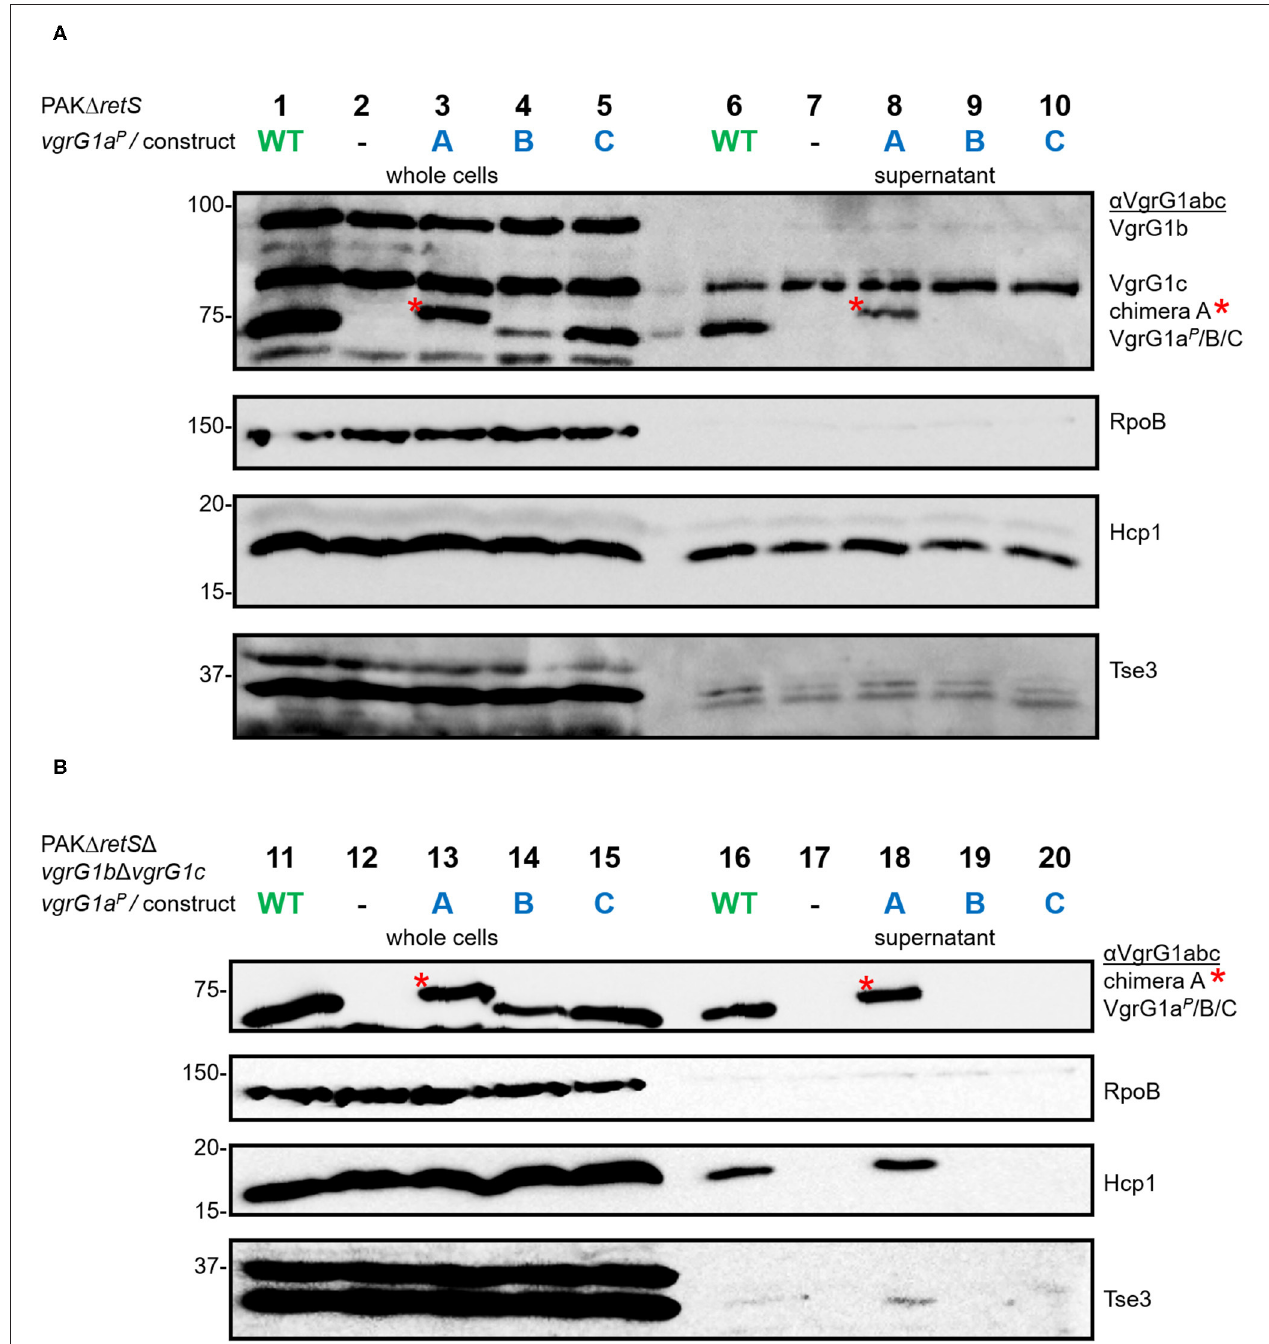
FIGURE 3 | Modifying the C-terminus of VgrG1a inhibits T6SS functionality. Representative figures of western blots from three independent secretion assays of (A) PAK 1 retS and (B) PAK 1 retS 1 vgrG1b 1 vgrG1c expressing Wild type VgrG1a P (WT), no VgrG1a P (–) or the chimeras A, B, C between VgrG1a P and VgrG1 A . Antibodies used (from top to bottom) are against VgrG1abc, RpoB, Hcp1, and the Hcp1-dependent effector Tse3 as indicated on the right.